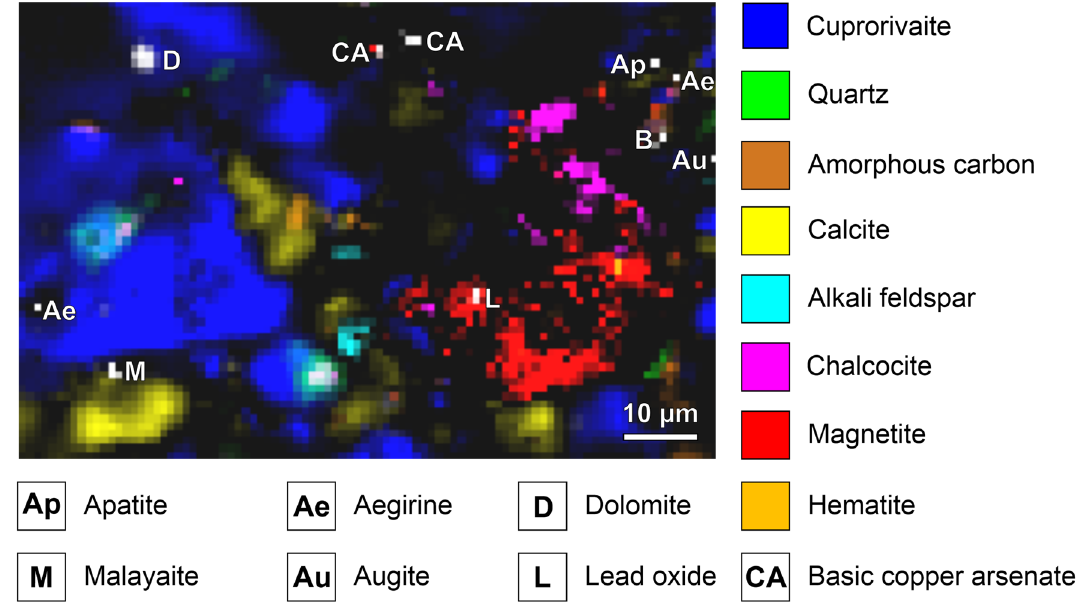
Figure 5. Raman map of the Egyptian blue paint layer. A remnant of the copper ore used as starting material in the pigment synthesis consists of chalcocite (and/or chalcopyrite) intergrown with magnetite. Hematite, basic copper arsenate, lead oxide and (perhaps) anatase can be interpreted as accessory minerals of the copper ore as secondary minerals in the oxidation zone of hydrothermal copper deposits. Due to the ambiguous assignment of the experimental spectra to existing reference data (see Fig. S14) 77–79 , we generally term these minerals basic copper arsenates with the sum formula Cu x (AsO 4 ) y (OH) 2x-3y . In line with our findings, an unspecified copper arsenate mineral was spotted by means of Raman spectroscopy (main peak at 861 cm −1 ) in green powder from a pigment pot excavated at Pompeii archaeological site, a multicomponent mixture including (without indications of quantity) malachite, goethite, hematite, calcite, quartz, albite, cerussite PbCO 3 , massicot PbO and Egyptian blue 80 . Irene Aliatis et al. link the presence of copper arsenate to the exploited deposit carrying copper ores, rul- ing out the possibility of degradation of arsenical copper residues in the glass phase of Egyptian blue as stated by Ahmed El Goresy with regard to pharaonic wall paintings 81 . The two sulphates osarizawaite PbCuAl 2 (SO 4 ) 2 (OH) 6 and natrojarosite NaFe 3 (SO 4 ) 2 (OH) 6 (see Fig. S16) can also be classified as oxidation products from a sulphidic copper ore, i.e. of accessory galena or pyrite, respec- tively. Due to the small amount (less than 0.2% of all assigned spectra) the intended use of natrojarosite as a yellow pigment can be excluded. The thermal degradation of natrojarosite comprises several steps, which are associated with inconsistent temperature specifications in different studies. According to the thermogravimetric data by Lei Chen, dehydroxilation yielding NaFe(SO 4 ) 2 and hematite at 447.5 °C is followed by desulphonation reactions at 682.6 °C and 716.5 °C resulting in Na 2 SO 4 , hematite and SO 3 82 . Thus, the temperatures needed to prepare Egyptian blue exceed the stability range of natrojarosite, which like ossarizawaite (dehydration at 460 °C, desulphonation at 760 °C 83 ) must have survived in colder zones in the clay pots or balls mentioned by Vitruvius, as mixing with water during application of the pigment might inverse a loss of crystal water, while the other decomposition reactions are irreversible in this respect. Accessory galena can be oxidised to anglesite PbSO 4 and finally be decomposed into plattnerite PbO 2 during roasting of the sulphidic copper ore. The exact stoichiometry of the lead oxide compounds in the paint layer cannot be determined by Raman spectroscopy, as plattnerite is known to easily decompose into massicot because of the action of the laser employed in a Raman experiment (see Fig. S10) 84 . This reason for the observation of massicot together with its trace amount (only in 0.03% of all assigned spectra) rules out its intentional addition as yellow lead oxide pigment. Evidences for the flux used in the synthesis of the pigment. Virtually no evidence for the presence of a glass phase was found, as only about 0.01% of the spectra were unambiguously assigned to silicate glass 85–87 . Causes for this are probably the prevailing process parameters (synthesis temperature and regime, locally too low temperature or too short reaction time for homogeneous melt formation) and the composition of the mix- ture of starting materials (low flux content, no significant SiO 2 excess) and not the loss of the glass phase by chemical weathering, as often assumed in studies dedicated to Egyptian blue 16, 29, 88 . There is some controversy on the theory of frit formation, initially favoured after the rediscovery of the blue pigment in the nineteenth cen- tury; while, for example, François Delamare assumes solid-state sintering with low and melt formation resulting in a glass fraction only with high alkali content 89, 90 , Trinitat Pradell et al. hypothesise nucleation and crystallisa- tion of cuprorivaite from the cooling silicate melt regardless of the amount of flux in the raw material blend 16 . At least on laboratory scale, cuprorivaite can be synthesised through pure solid-state reactions, which requires the